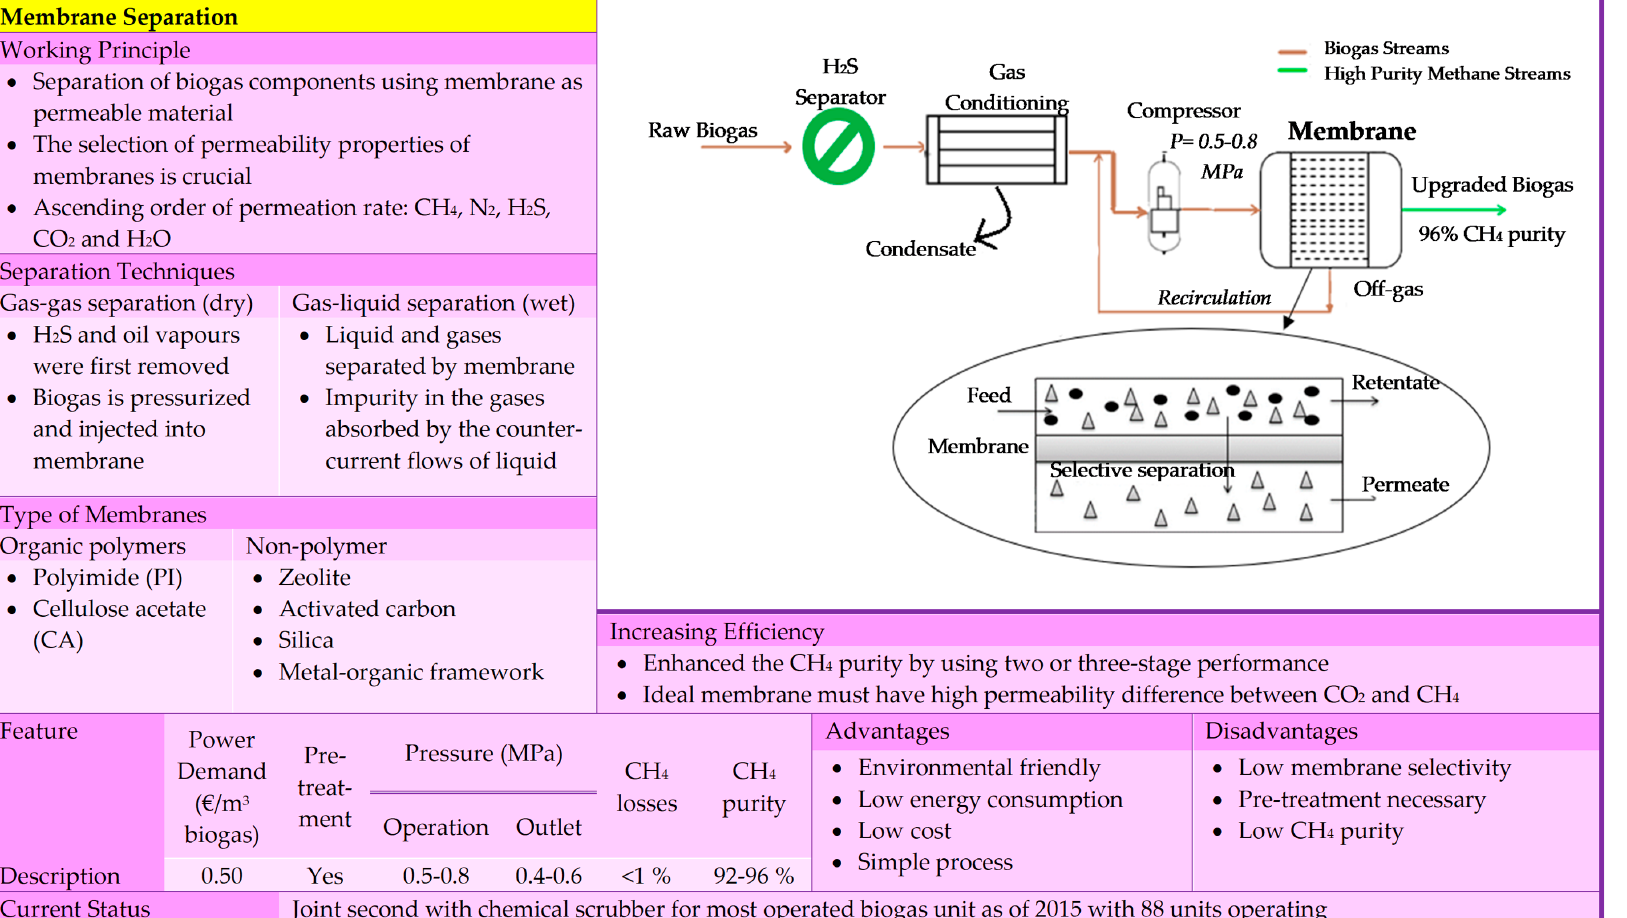
Figure 5. Summary of base knowledge of membrane separation technology [20,21,25,27–29,38,39].